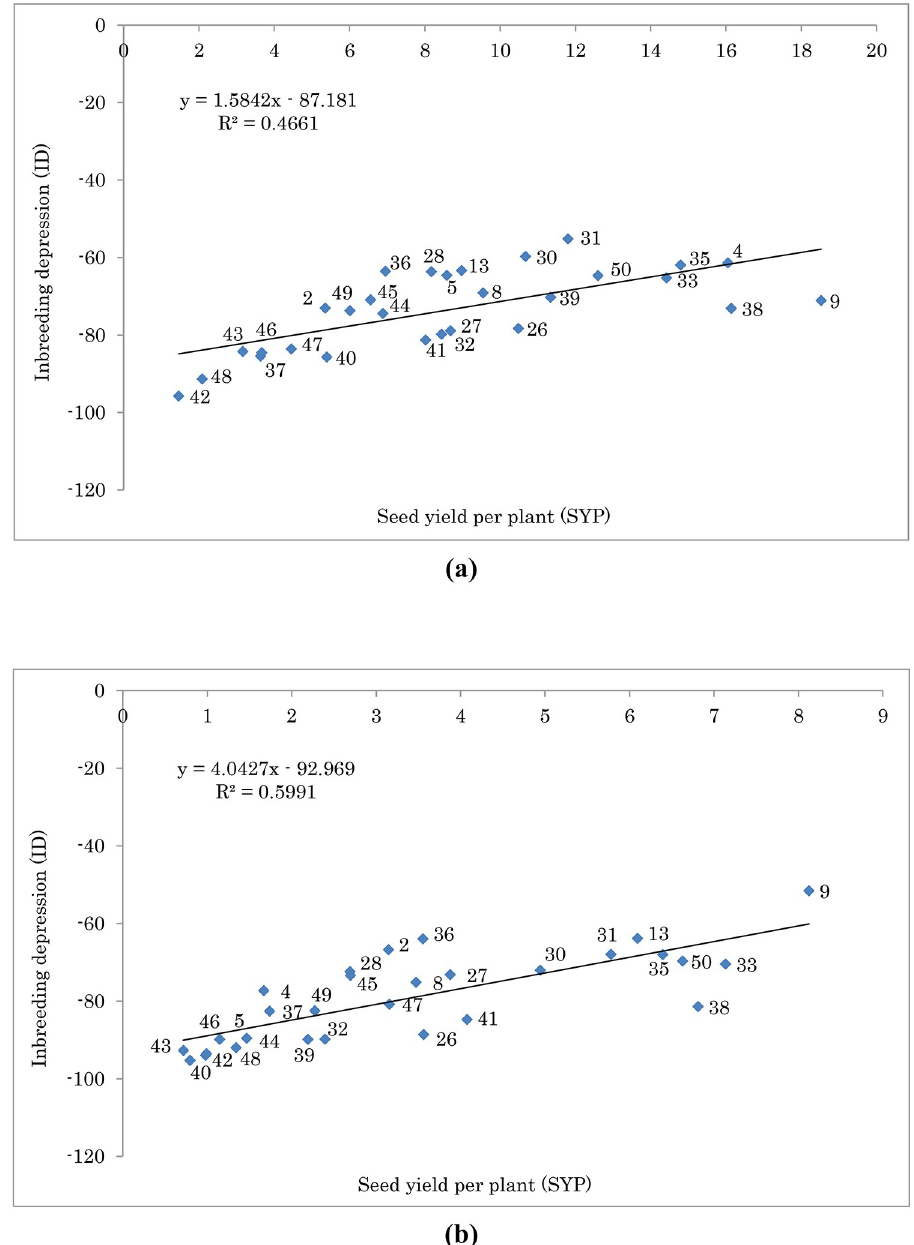
Fig 3. Biplot of seed yield per plant (SYP) vs. inbreeding depression (ID) for S1 population of fennel under (a) normal condition and (b) water deficit condition. There was significant association between SYP and ID under normal (r = 0.68 �� ) and water deficit (r = 0.77 �� ) conditions. The F-test indicated that the model is significant for normal and water deficit conditions in 0.01 probability